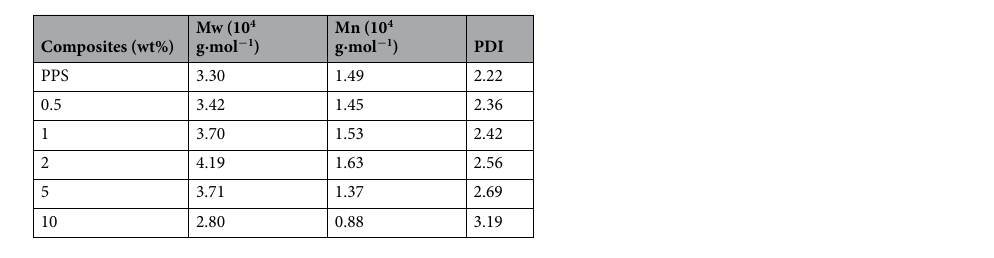
Table 1. Molecular weight and polydispersity index of different